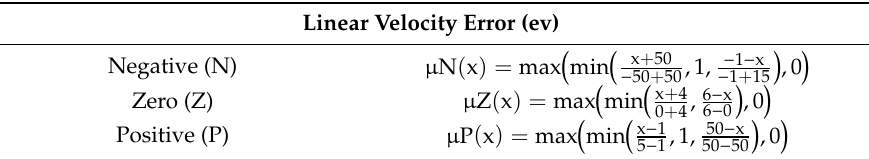
Table 5. Mathematical representation of the input 1 membership function.